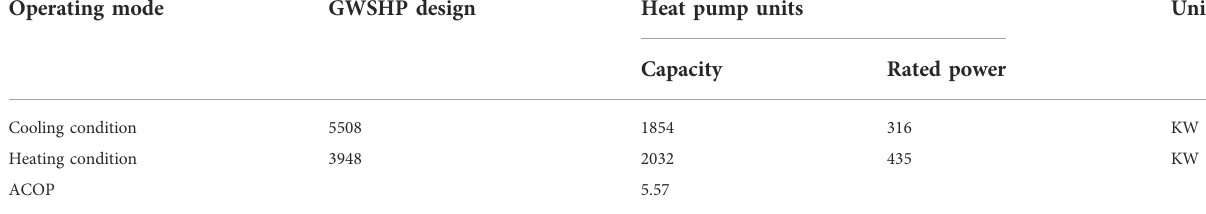
TABLE 5 GWSHP parameters in different conditions.